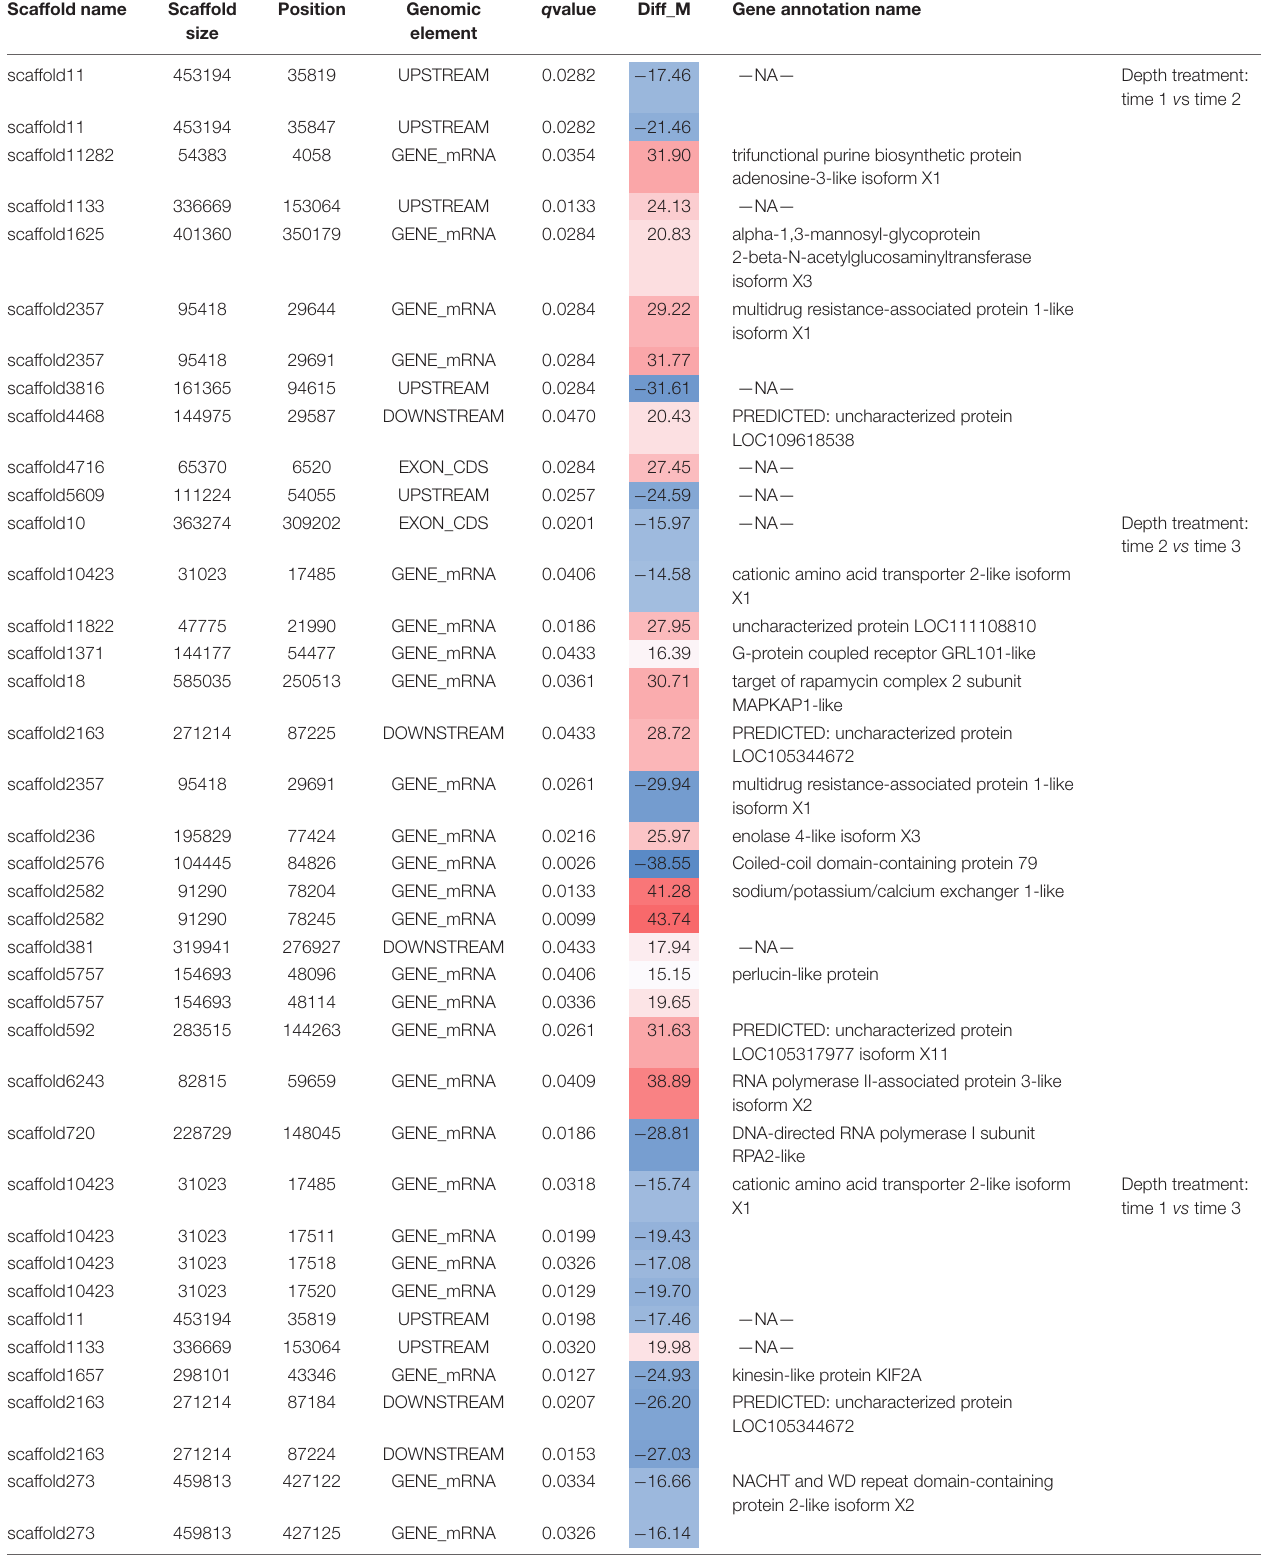
TABLE 2 | All significantly differentially methylated positions ( q value < 0.05) for treatment comparisons. Scaffold